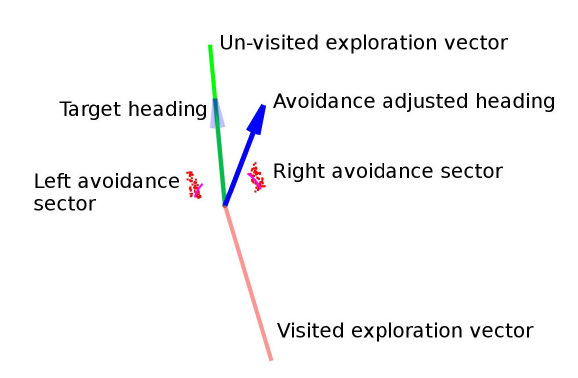
Figure 11. Interpretation of navigation diagrams.